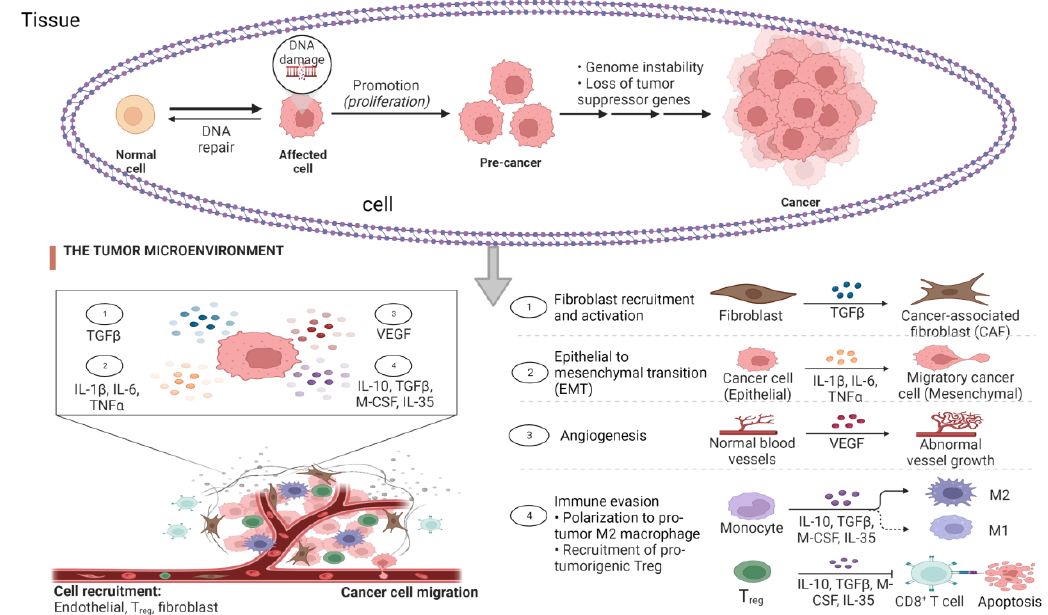
Figure 2. Stages of cancer and the role of inflammatory biomarkers. The tumor microenvironment (TME), comprising the fibroblasts and vascular cells as well as the inflammatory immune cells, is predominated by the macrophages after DNA damage without DNA repair with evidence of increased concentration of cytokines leading to cytokine storm. The presence of macrophages in the tumor tissue is positively correlated to the activation of cancer stages, which include cellular transformation, promotion, survival, proliferation, angiogenesis, and metastasis. Antioxidant agents tend to reduce the excessive production of ROS and the subse- quent oxidative stress. They carry out these functions by preventing cellular damage, thereby reacting to and eliminating oxidizing free radicals to find relevance in adjuvant chemotherapy [63]. Moreover, several studies have suggested the combination of antiox- idants in chemotherapy for specific cancer settings [64]. Cytotoxic cancer chemotherapeu- (Figure 3) is important during the management and treatment of cancer to reduce the se- verity of ROS without interfering with the drug’s antineoplastic activity [65]. Since there this review attempts to emphasize the importance of future research targeting specific and management of cancer. Table 2. Anti-inflammatory and anticancer activities of micronutrients through regulation of spe- cific cell signaling pathways.